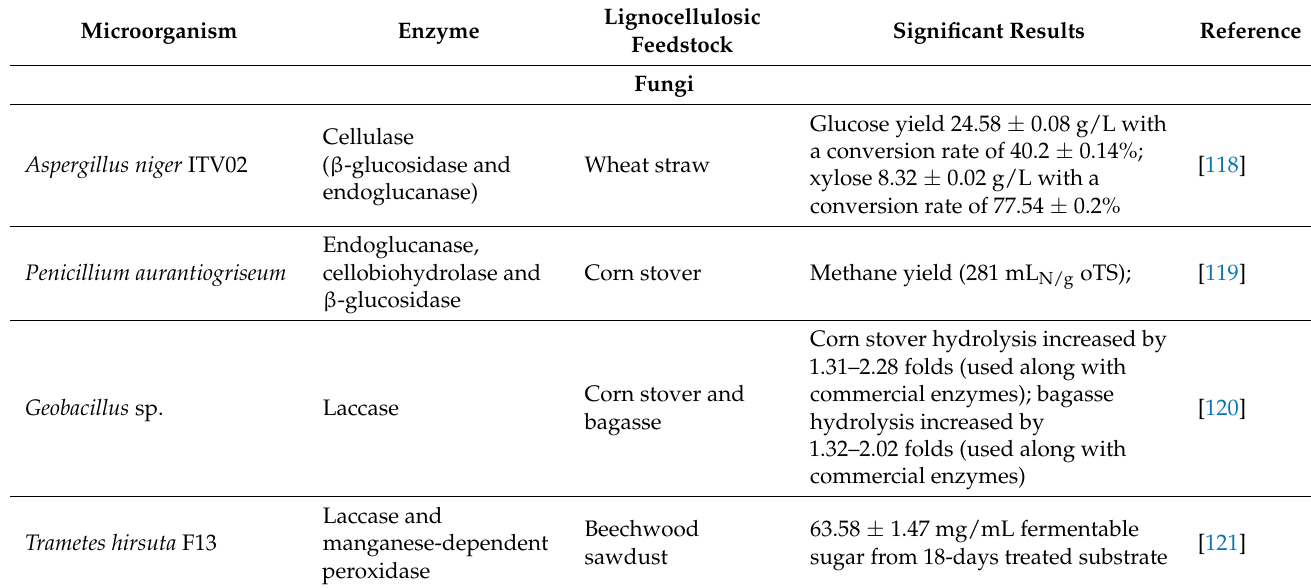
Table 1. Degradation of different lignocellulosic feedstocks by various fungal and bacterial lignocel- lulolytic